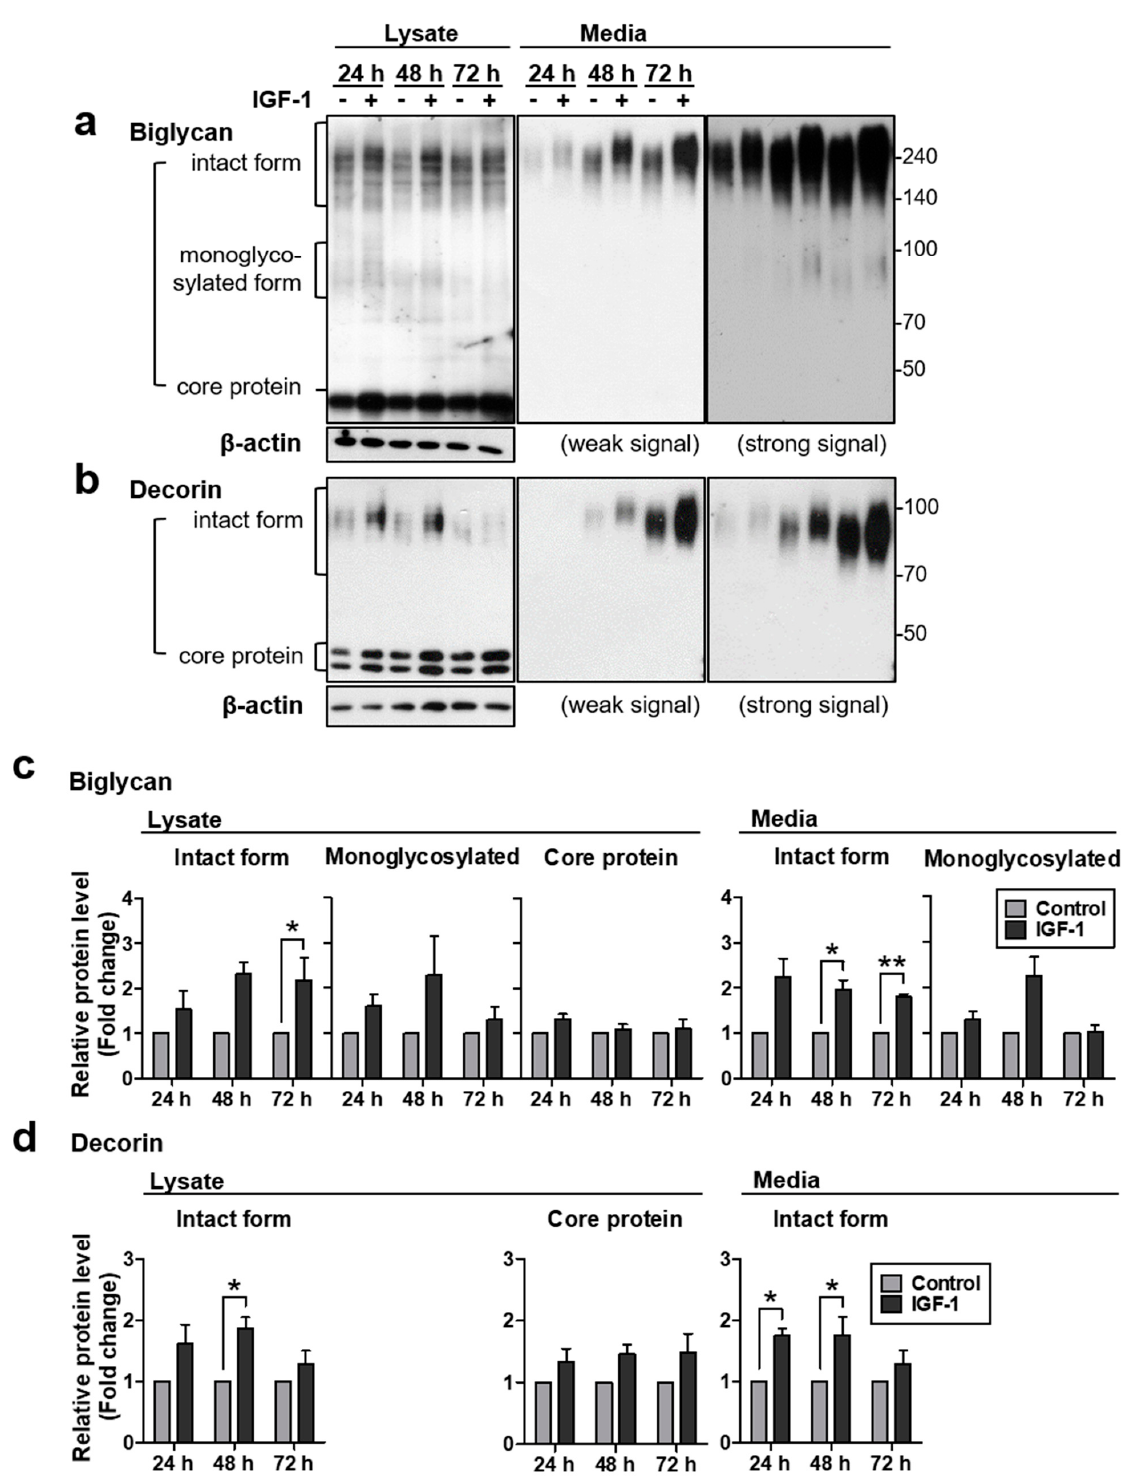
Figure 1. Insulin-like growth factor-1 (IGF-1) increased biglycan and decorin protein levels, but not mRNA expression in normal human dermal fibroblasts (NHDFs). Primary NHDFs were treated with 250 ng/mL of IGF-1 and harvested indicated time points. Protein levels of ( a ) biglycan and ( b ) decorin in cell lysates and conditioned media were analyzed by western blotting. ( c , d ) Relative protein amounts were analyzed using ImageJ. Band intensity was normalized to that of β -actin. Values represent the mean ± standard error of the mean (SEM) of data ( N = 4, We performed 4 independent experiments using primary cells from 4 different individuals.). Statistical comparison was made using paired t -test. (* p < 0.05, ** p <